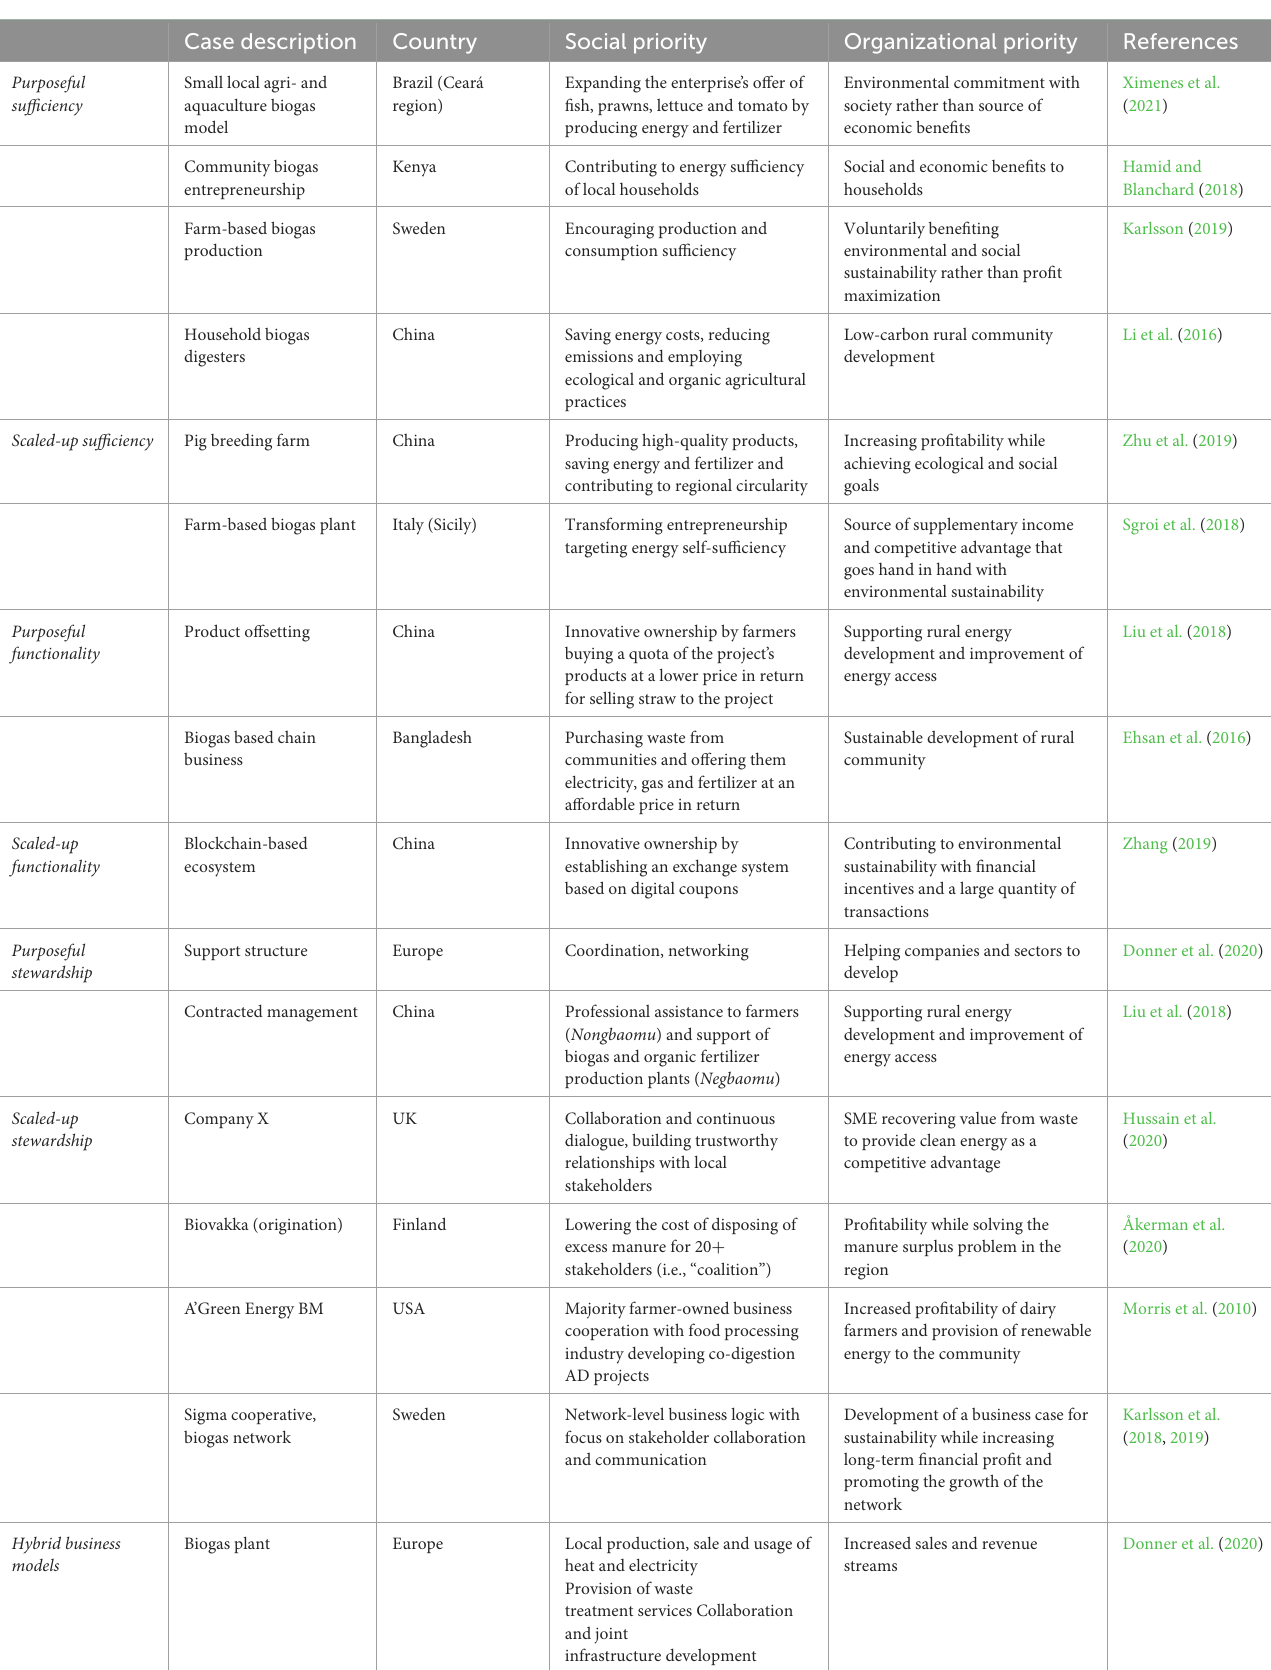
TABLE 2 Case studies and their technological, social and organizational value